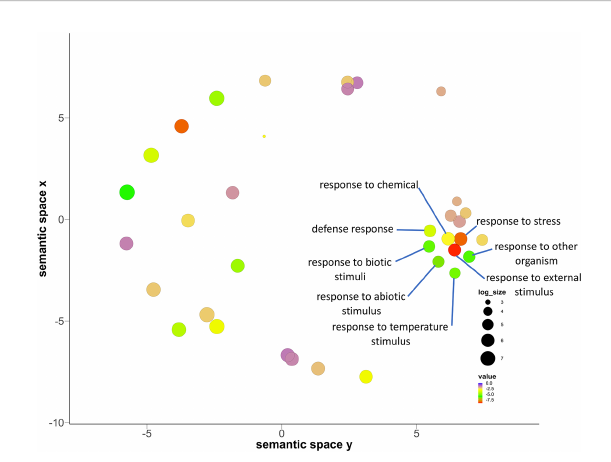
FIGURE 2 Venn diagram showing shared differentially expressed genes across four published transcriptomic datasets. The datasets differed in the conditions examined: Shivhare A at 40 DAS (Shivhare et al., 2020b) compares a drought tolerant genotype with a drought sensitive genotype under drought stress. The other three datasets [Jaiswal vegetative (Jaiswal et al., 2018) and Shivhare B vegetative and reproductive (Shivhare et al., 2020a)] compare drought tolerant genotypes under well-watered versus drought stressed conditions.